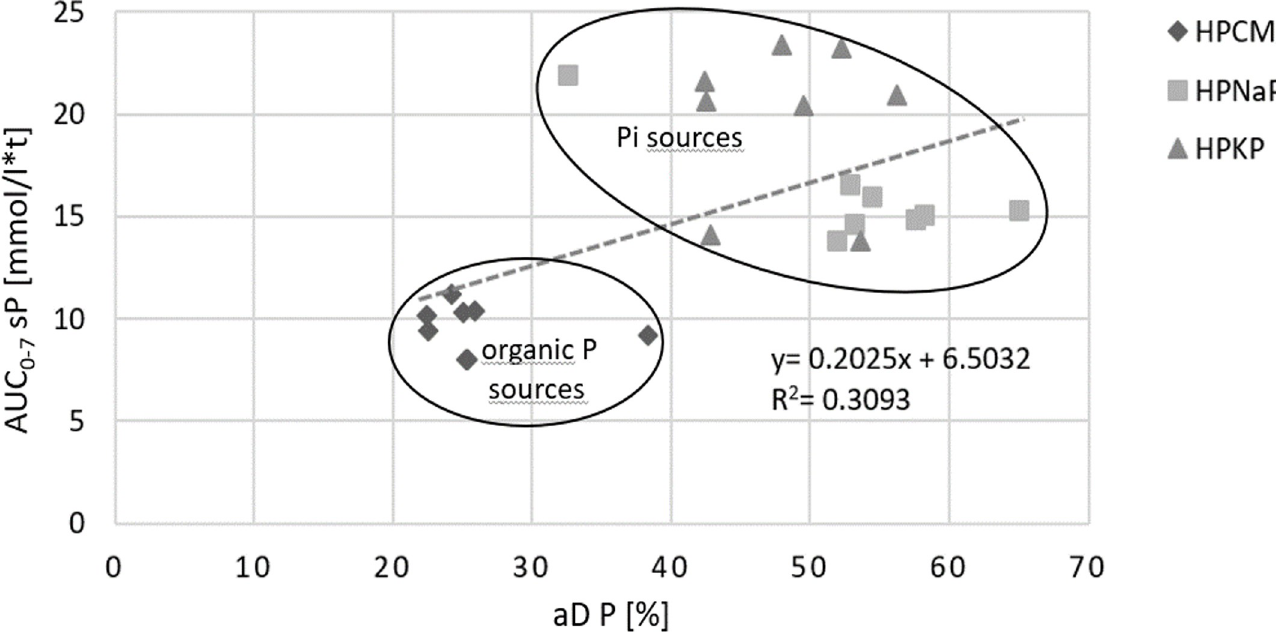
Fig 5. Correlation between the aD P [%] and the AUC 0-7 (sP) [mmol/l � t] in dogs after feeding one control diet and 3 different HP diets containing different phosphorus sources. aD = apparent digestibility, HP = high phosphorus